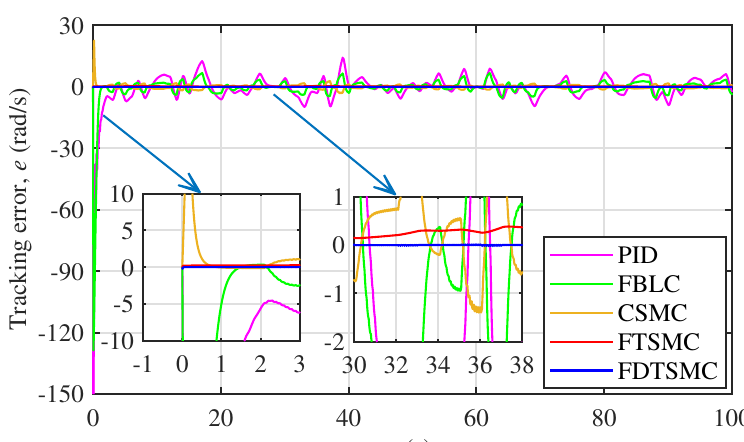
Figure 6. High-speed shaft rotational speed tracking.